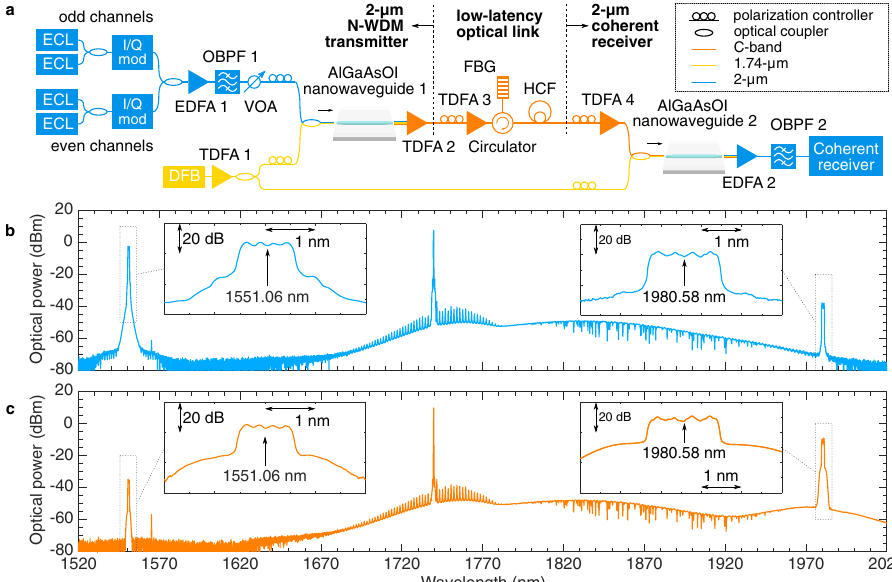
Fig. 3 2- μ m-band coherent transmission based on a pair of spectral translators with 4 × 32 Gbaud 16-QAM signal. a The 2- μ m-band N-WDM transmitter is based on a spectral translator (AlGaAsOI nanowaveguide 1) to convert the C-band signal to the 2- μ m band. The 2- μ m-band coherent receiver is based on a second spectral translator (AlGaAsOI nanowaveguide 2) to convert the 2- μ m-band signal back into the C band. The pump for the spectral translators is generated through a distributed feedback (DFB) laser working at 1739.74 nm and a short-wavelength thulium-doped fi bre ampli fi er (TDFA 1). The 2- μ m-band signal is transmitted through a ~1.15-km hollow-core fi bre (HCF) link with a low latency of 3.82 μ s. b Transmitter-side spectral translation from 1551.06 to 1980.58 nm with an output CE of − 35.4 dB. c Receiver-side spectral translation from 1980.58 nm back to 1551.06nm with an output CE of − 24.5 dB. The difference in the CE is due to the difference in the AlGaAsOI nanowaveguides and the fact that the 2- μ m-band signal experiences more loss during coupling and propagation (ECL external cavity laser, EDFA erbium-doped fi bre ampli fi er, OBPF optical bandpass fi lter, VOA variable optical attenuator, FBG fi bre Bragg